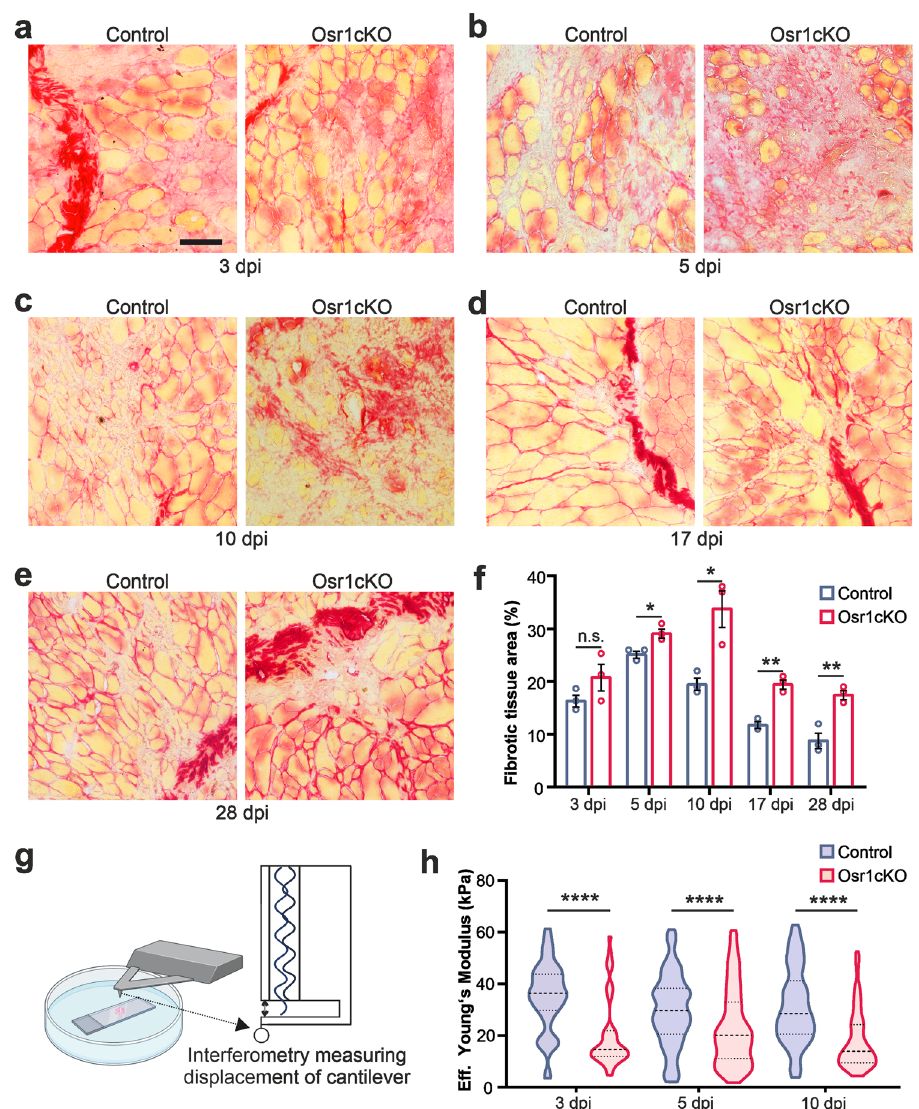
Fig. 2 Loss of Osr1 results in persistent fi brosis and tissue softening. a – e Picrosirius red staining on control and Osr1cKO muscle sections at indicated days post-injury (dpi). f Quanti fi cation of picrosirius red staining ( n = 3). Data are presented as mean ± SEM. g Schematic representation of nanoindentation method to assess tissue stiffness. h Quanti fi cation of nanoindentation stiffness measurements of the injured area in muscle tissue sections of control and Osr1cKO mice ( n = 3). Violin plots show full data range, mean value, fi rst and third quartiles are indicated. P ‐ value in ( f , h ) calculated by two ‐ sided unpaired t test between control and Osr1cKO samples for each time point; * p < 0.05, ** p < 0.01, **** p < 0.0001. N ‐ numbers indicate biological replicates (mice per genotype). Scale bars: 100 μ m in ( a – e